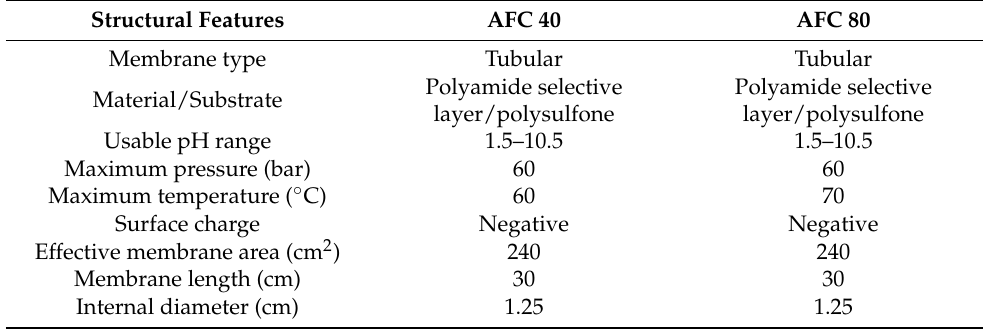
Table 1. Characteristics of the NF membranes